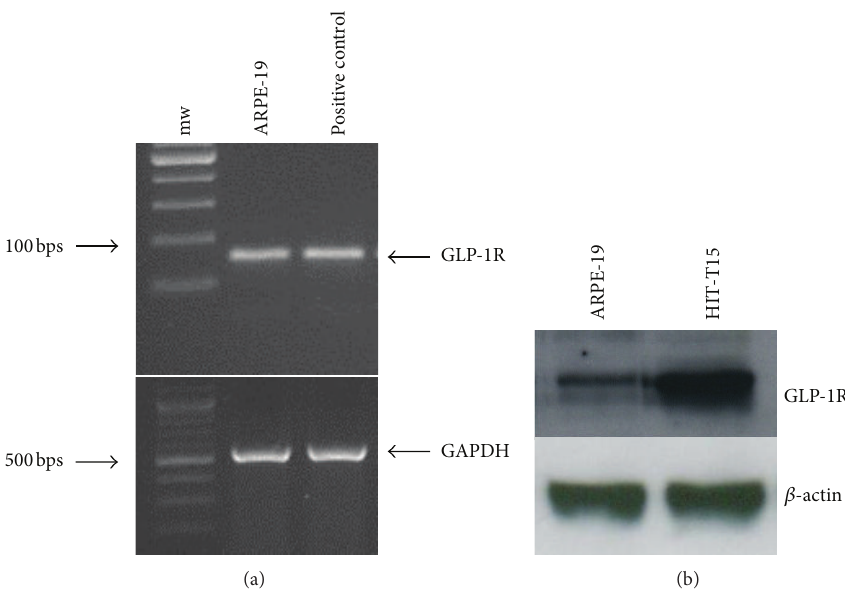
Figure 1: GLP-1R is expressed in ARPE-19 cells. (a) RT-PCR showing GLP-1R mRNA expression in human ARPE-19 cells cultured in standard medium. The expected RT-PCR product size is 98 bp. Glyceraldehyde 3-phosphate dehydrogenase (GAPDH) was utilized as an external control. Representative agarose gel of three different experiments. (b). Representative western blot analysis of human GLP-1R protein levels ( ∼ 65kD) showing that GLP-1R protein is expressed in ARPE-19 cells. Lysates from the pancreatic insulin secreting cell line HIT-T15 were used as a positive control. Representative western blot analysis of three different experiments is shown.